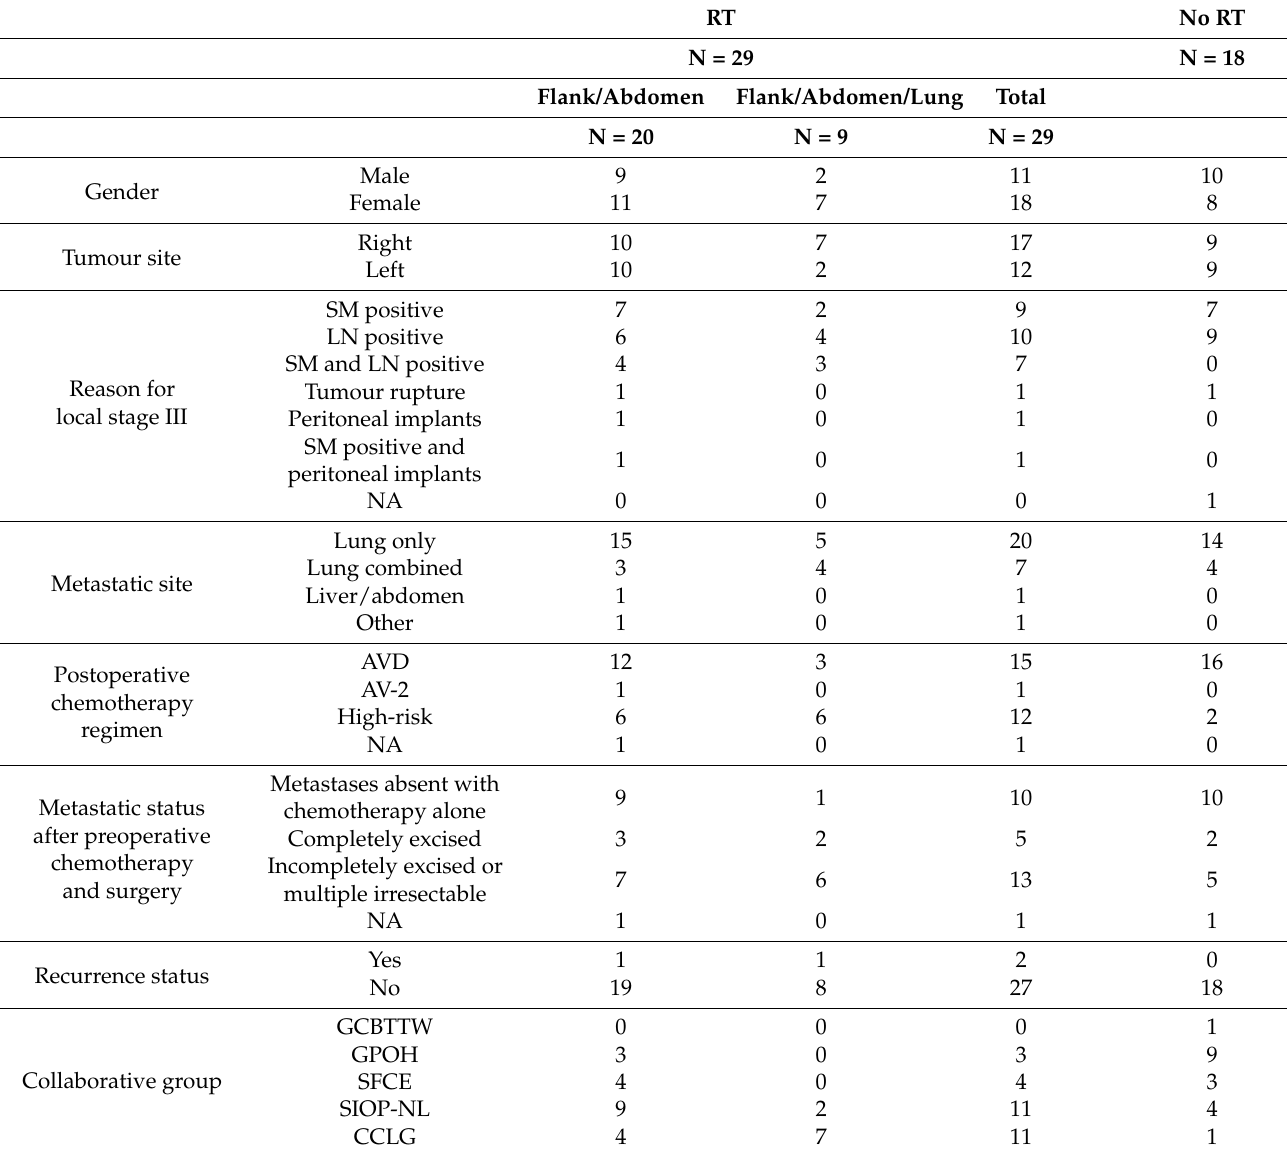
Table 1. Patient, tumour, and treatment characteristics of totally necrotic, local stage III, stage IV Wilms